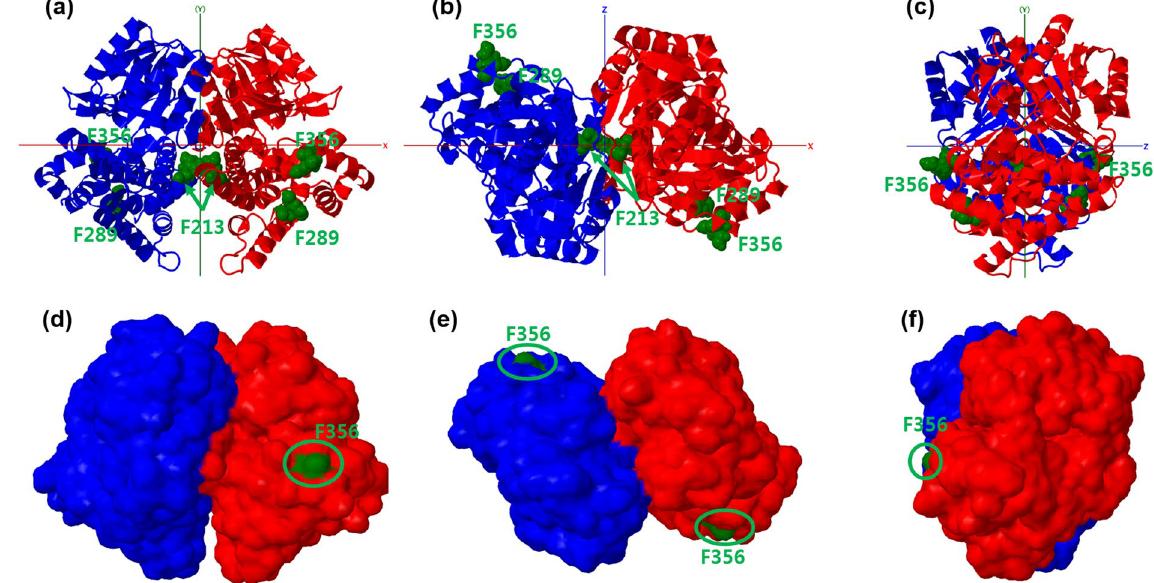
Figure 4. MDH dimer structure. Cartoon image ( a – c ) and molecular surface model ( d – f ) of the dimer. Chain A, red; chain B, blue. Mutation positions are shown in green space-fill models accompanied by the residue name and number. The dimer structures are oriented in the XY ( a , d ), XZ ( b , e ), and YZ ( c , f ) planes,